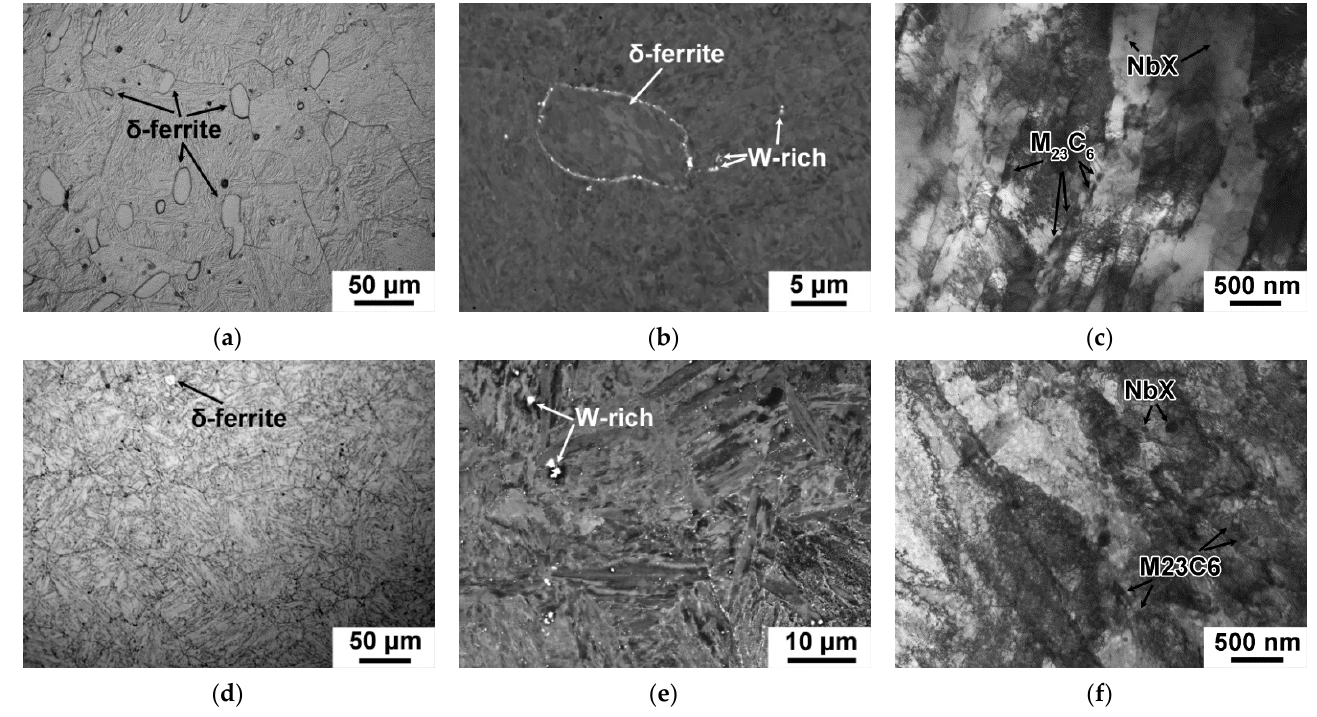
Figure 8. Typical microstructures in the 12CrNb0.003N steel subjected to the CHT ( a – c ) and TMP ( d – f ) obtained by optical microscope ( a , d ), SEM ( b , e ), and TEM ( c , f ).